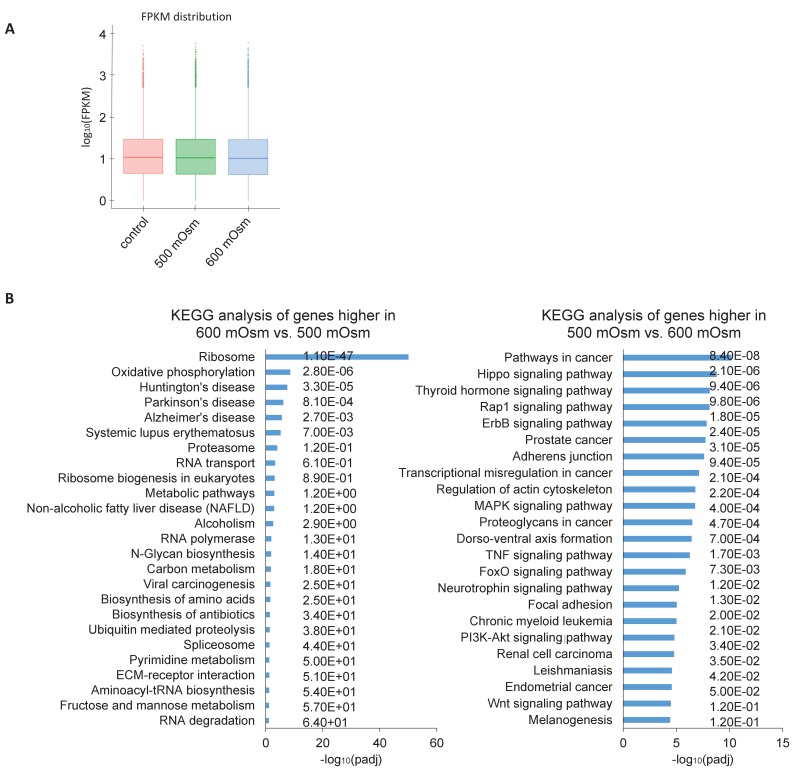
Hyperosmotic stress intensity alters expression of genes involved in ribosomal machinery and cancer signaling pathways.(A) Similar numbers of reads were obtained between treatments with low- and high-intensity hyperosmotic stress. (B) KEGG analysis shows the most common pathways shared between differentially expressed genes under the indicated treatments. Q scores representing false discovery rate (FDR) are reported on the right.